Question: In a single sentence, describe what this figure presents.
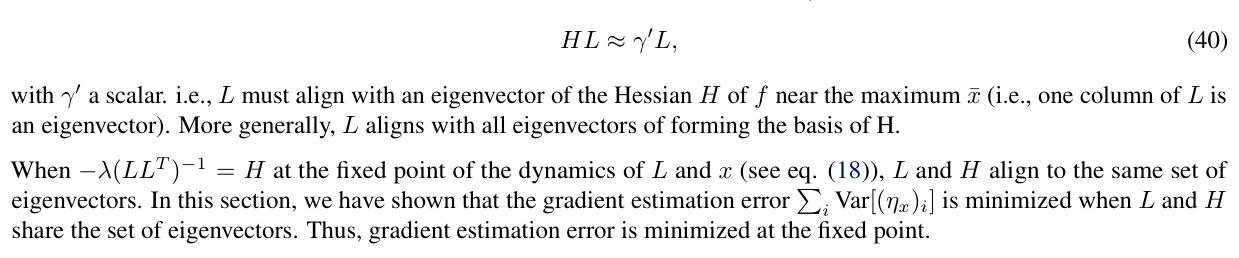
Answer: shows that the covariance −Cov[Xi(v), Yi(v)]i and, in turn, the variance of dx is minimized when the smoothing kernel is aligned to the curvature of the objective function. That is, the noise in the step dx is minimized when the window shape matches the curvature of f near its maximum.